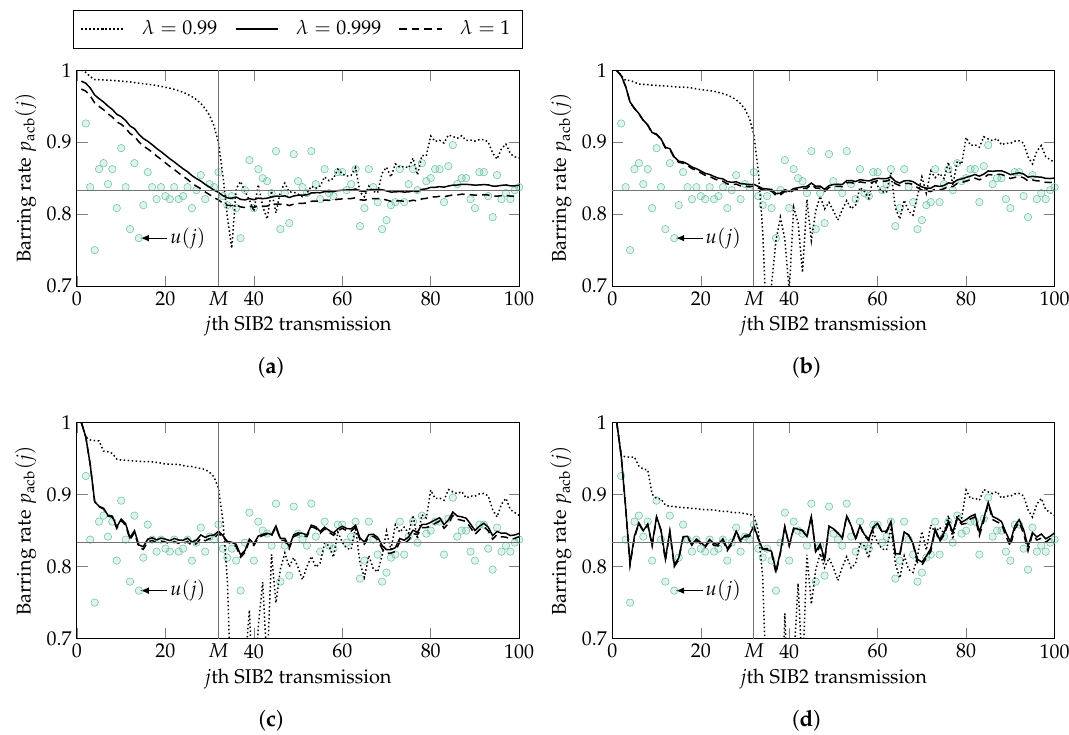
Figure 5. Ratio of idle to available resources u ( j ) and barring rate p acb ( j ) calculated at the j th SIB2 for a single simulation run and r = 54 for the RLS algorithm with λ = { 0.99,0.999,1 } and ( a ) δ = 0.001; ( b ) δ = 0.01; ( c ) δ = 0.1; and ( d ) δ = 1. The horizontal line is located at E [ u ( j )]